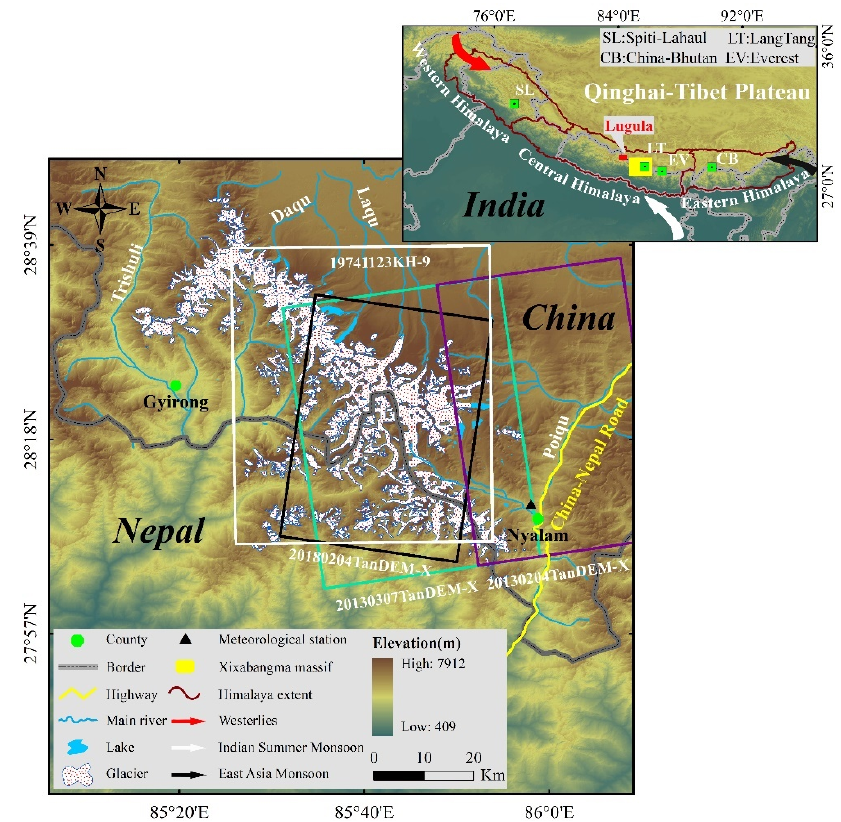
Figure 1. Distributions of glaciers and glacial lakes in the Xixabangma massif, Central Himalayas. The white rectangle denotes the coverage of the KH-9 image. The chrysoprase, black and purple rectangles denote the coverage of the TanDEM-X images acquired on different dates.